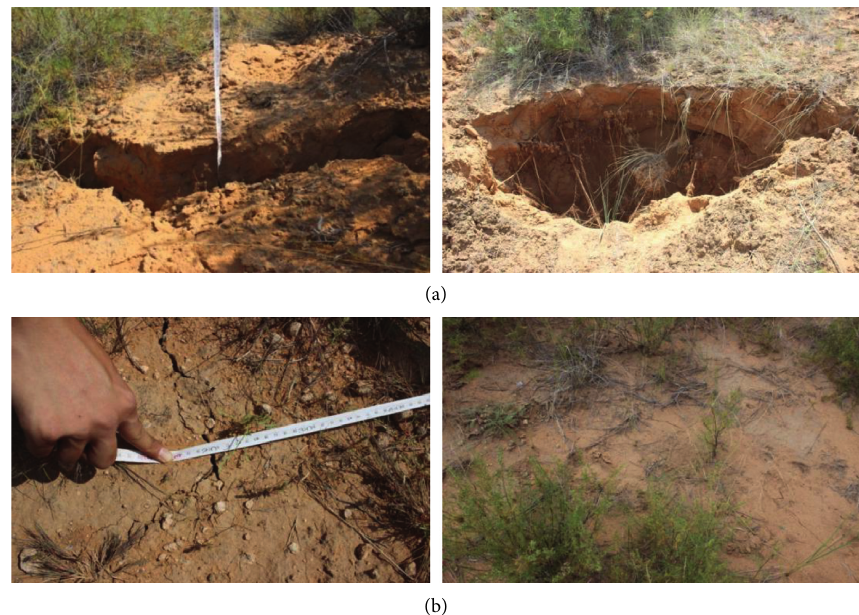
Figure 11: Comparison of surface fractures. (a) Surface fractures in the conventional coal mining process. (b) Surface cracks in the roadway retained by roof cutting and pressure relief.